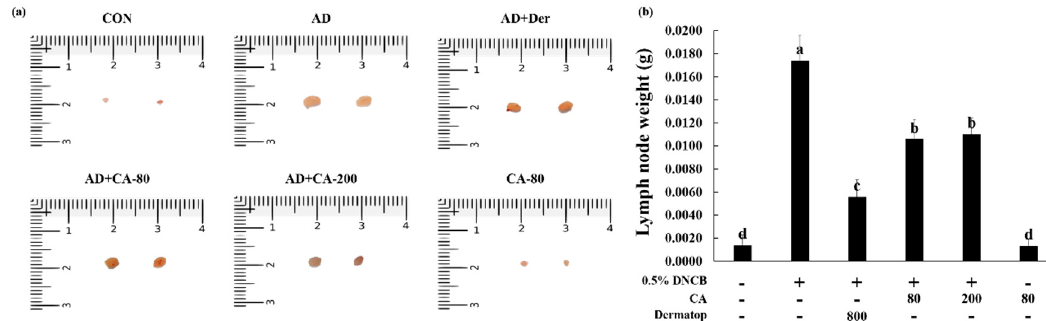
Figure 6. ( a , b ) Photographs represent the size and weight of lymph nodes. Values represent the mean ± SD. Values with different letters were significantly different according to Duncan’s multiple range test ( p < 0.05).